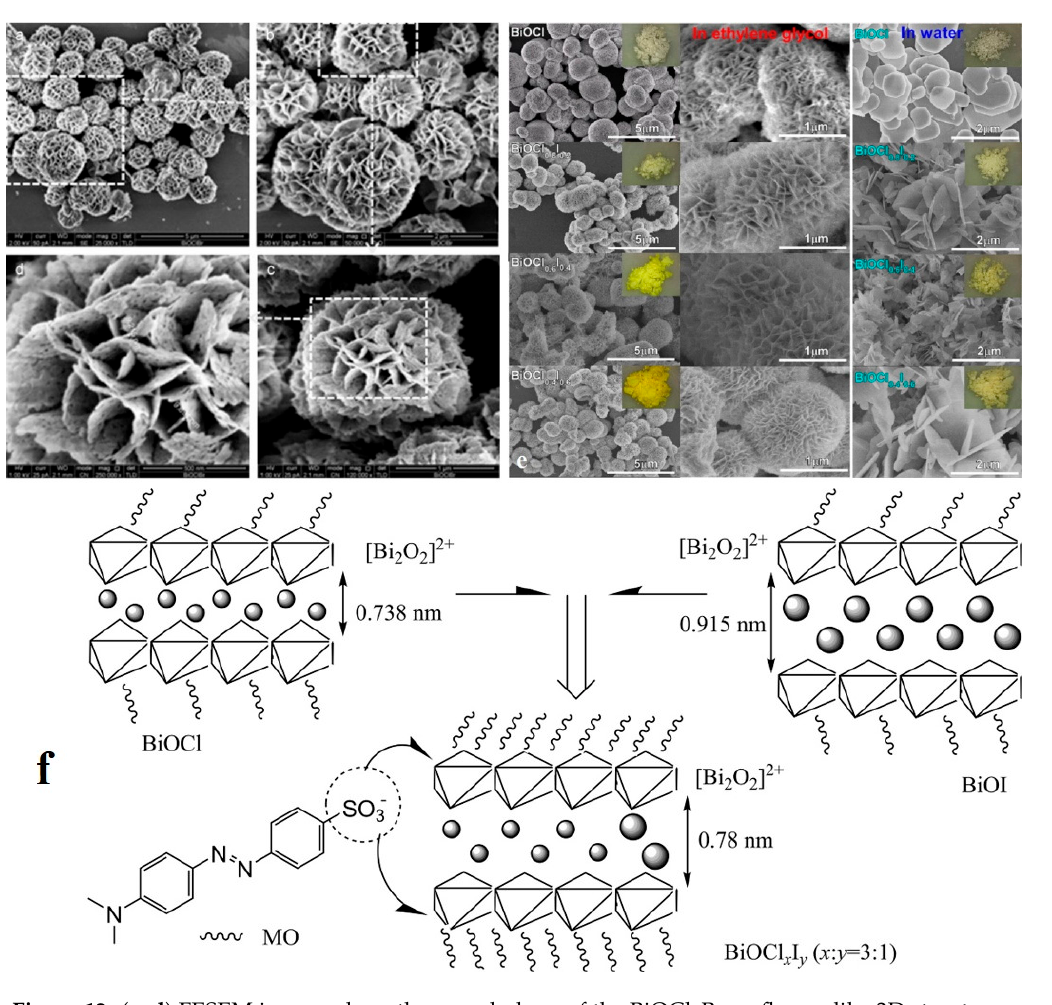
Figure 12. ( a – d ) FESEM images show the morphology of the BiOCl x Br 1 − x flower-like 3D structures at different magnifications. Reproduced with permission [27]. Copyright 2015, John Wiley and Sons. ( e ) SEM images implying the morphology of BiOCl x I 1 − x ( x = 1, 0.8, 0.6, and 0.4) synthesized in ethylene glycol (the first two columns from left) and water (the last column). The inset camera pictures imply the color of the related samples. Reproduced with permission [197]. Copyright 2014, Elsevier. ( f ) Schematic illustration of the underlying mechanism for the enhanced MO adsorption in a BiOCl x I y solid solution. Reproduced with permission [198]. Copyright 2016,